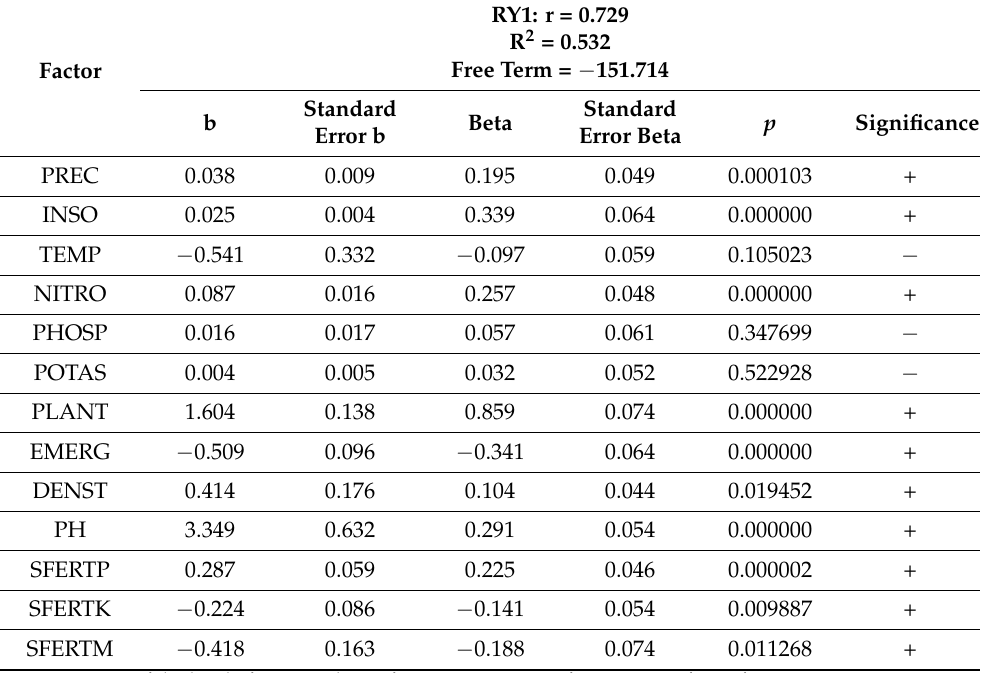
RY1: r = 0.729 R 2 =